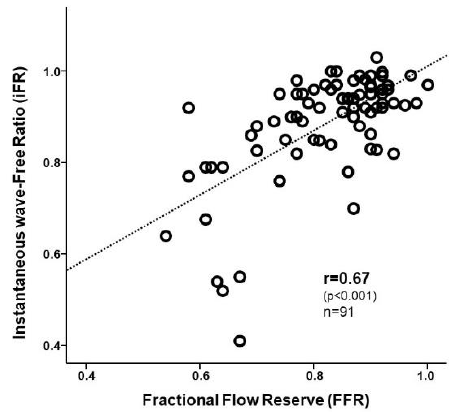
Figure 1. Correlation between the instantaneous wave-free ratio (iFR) and the fractional flow reserve